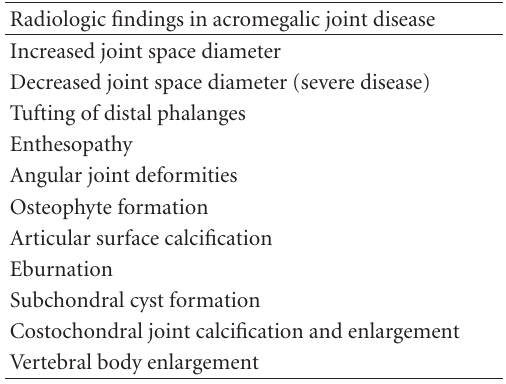
Table 1: Review of radiological findings in acromegaly